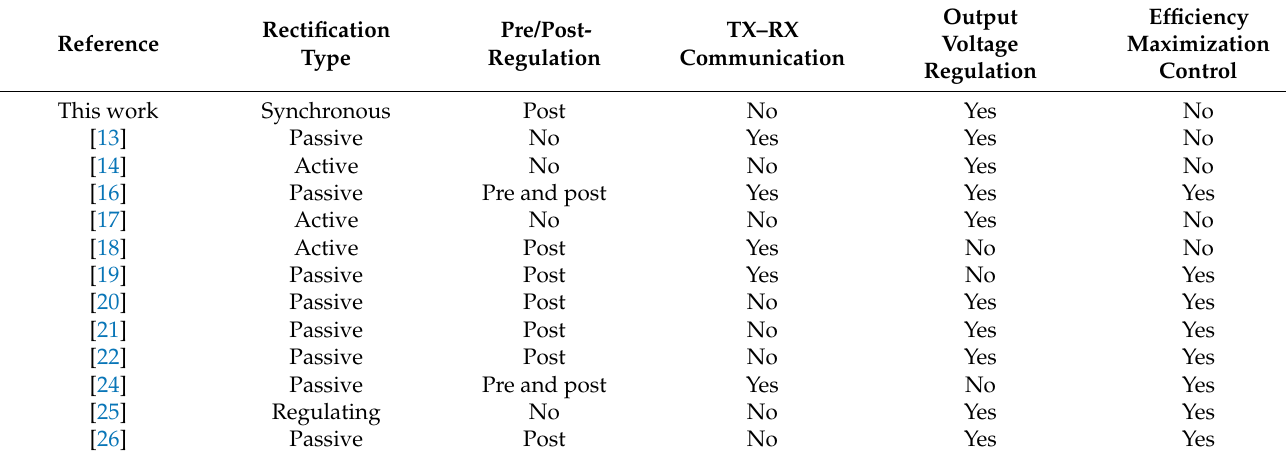
Table 10. IPTS functionality